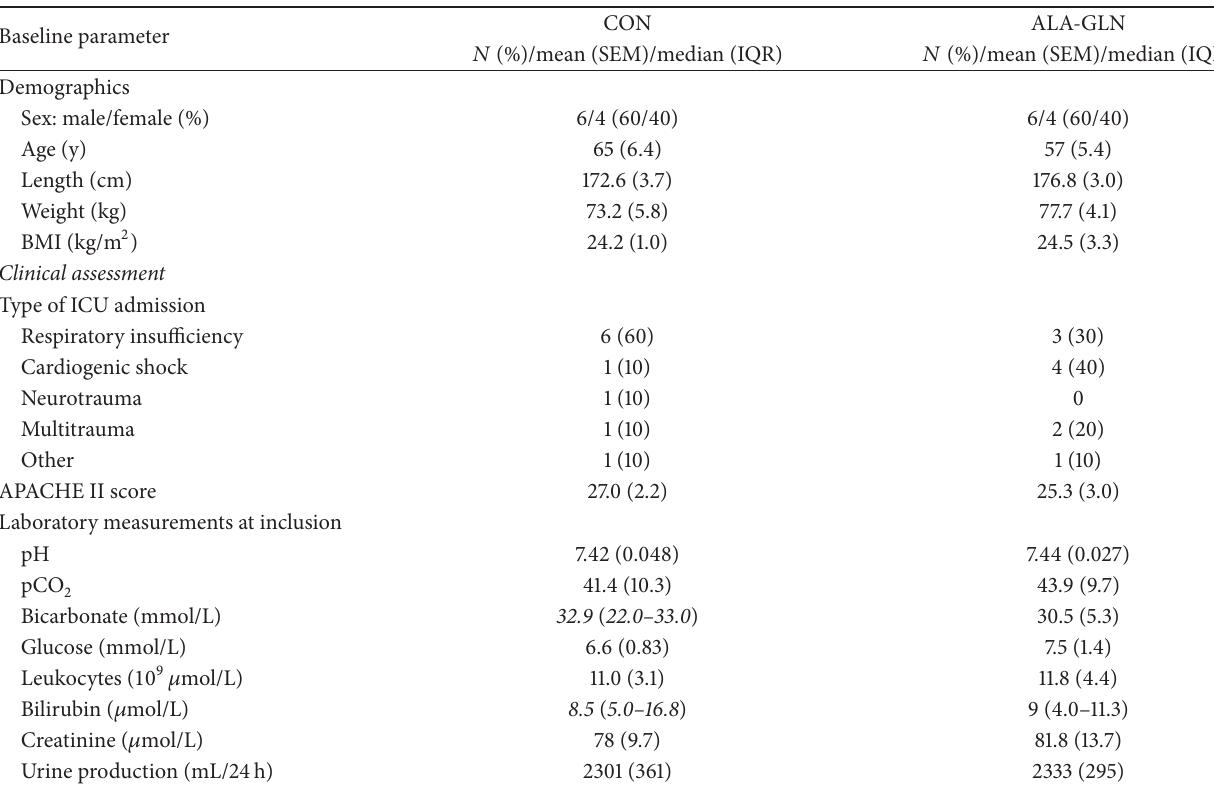
Table 3: Baseline